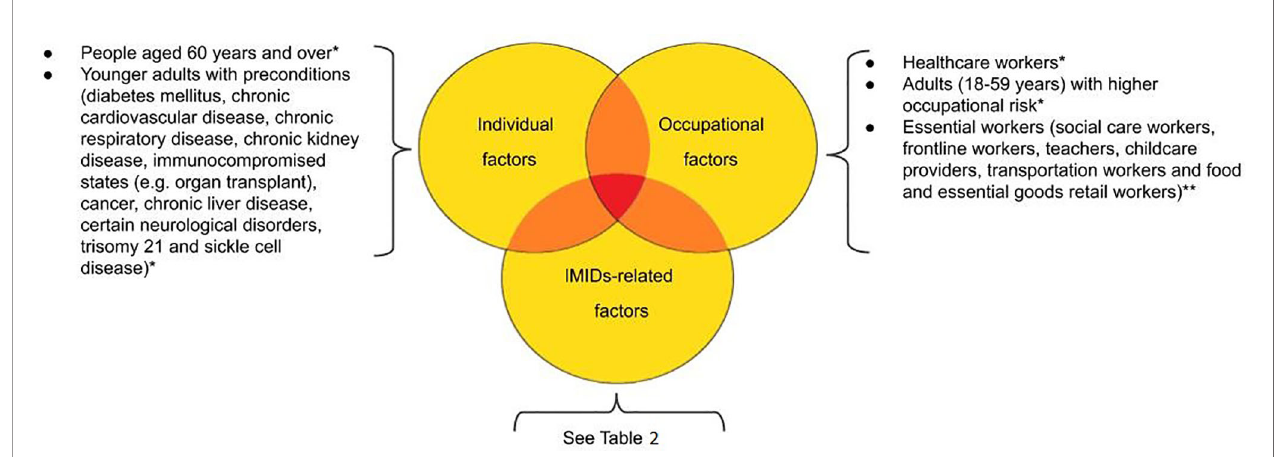
FIGURE 1 | Prioritization proposal according to patients ’ individual-, occupational- and IMIDs-related risk factors. *According to ECDC (European Centre for Disease Prevention and Control) Technical Report (https://www.ecdc.europa.eu/sites/default/ fi les/documents/COVID-19-vaccination-and-prioritisation-strategies.pdf). **to evaluate; not included in the mathematical